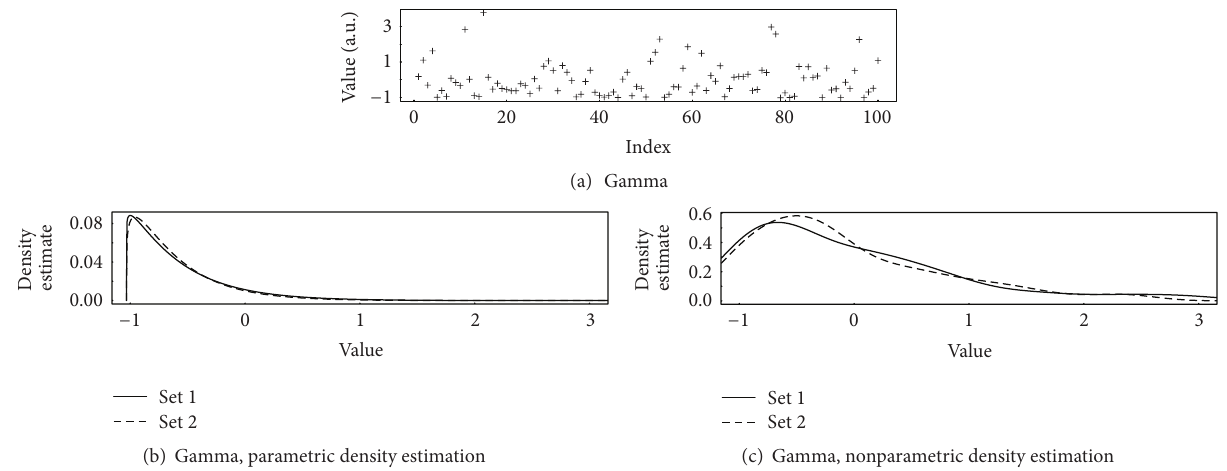
Figure 2: The same as Figure 1, but 100 transformed observations 𝑦 𝑖 = (𝑥 𝑖 − 𝑥)/̂𝜎 from the gamma (shape = 1, rate = 0.1) distribution.